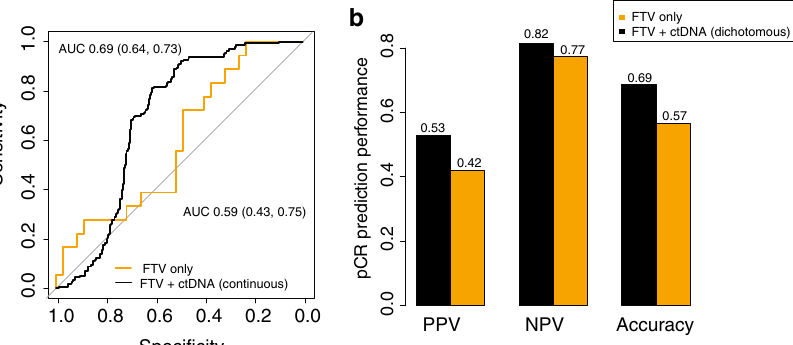
Fig. 4 Additive value of ctDNA to FTV-based predictors of pCR at T1. a Area under the curve (AUC) for prediction of pCR early during NAC (T1: 3 weeks after initiation treatment) for FTV alone and FTV + ctDNA treated as a continuous variable. b Positive predictive value (PPV), negative predictive value (NPV) and accuracy for prediction of pCR of FTV alone and FTV + ctDNA treated as a dichotomous variable.